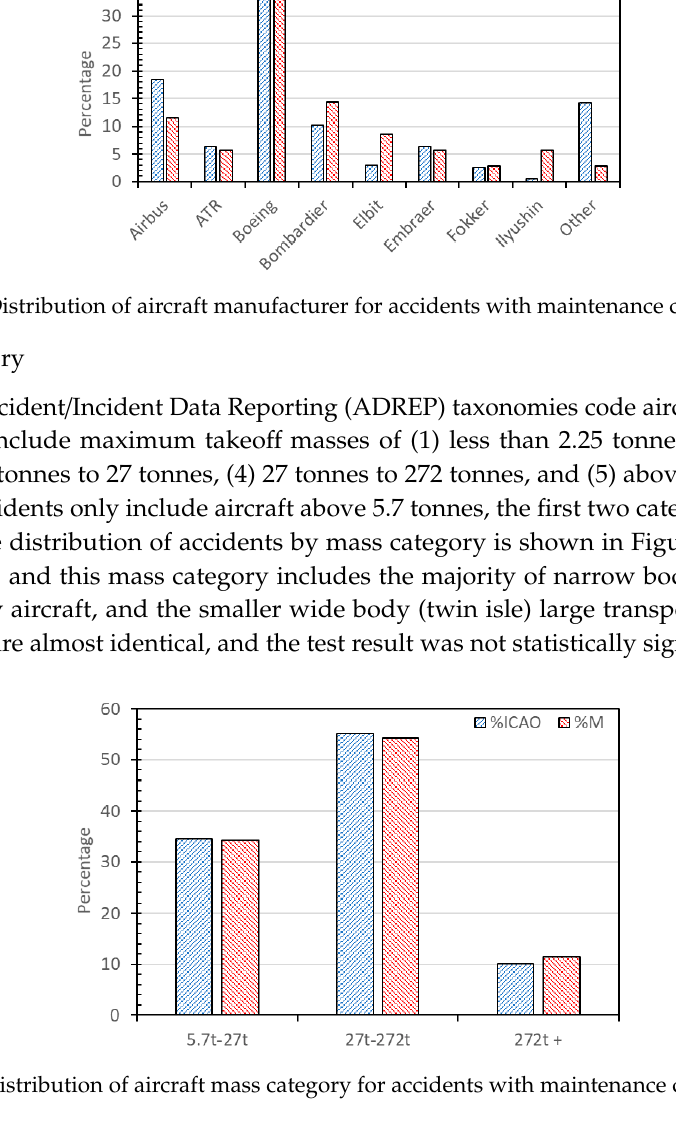
( b ) Figure 7. Distribution of aircraft engines for accidents with maintenance contributions: ( a ) the type of engine; ( b ) the number of engines. 4.2.8. Maintenance Issue From Figure 8a, ‘general’ (substandard practices, insufficient maintenance, qualification, training, etc.) has the highest count, and the observed variation is statistically significant. Engine and part issues are as expected, while ‘AD/SB’ (failure to follow airworthiness directives or service bulletins) and ‘PD’ (repaired previous damage), have low counts. Figure 8b shows the distribution